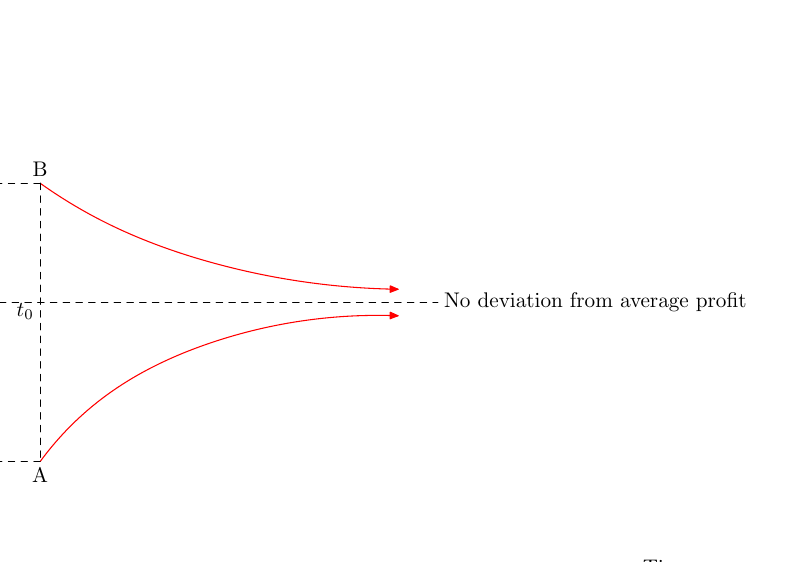
Figure 3. The figure shows two companies, A and B, where the profit rate deviation from the average profit rate in the industry at time t 0 is π 1 and π 2 , respectively. The profit rate converges towards a state where there is no difference between the two companies’ profit rates and the industry